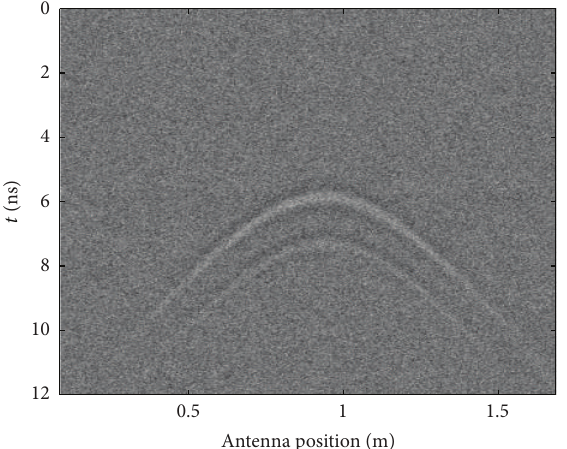
Figure 5: 35 dBW white Gaussian noise is added to Figure 2(a) after mean filtering.